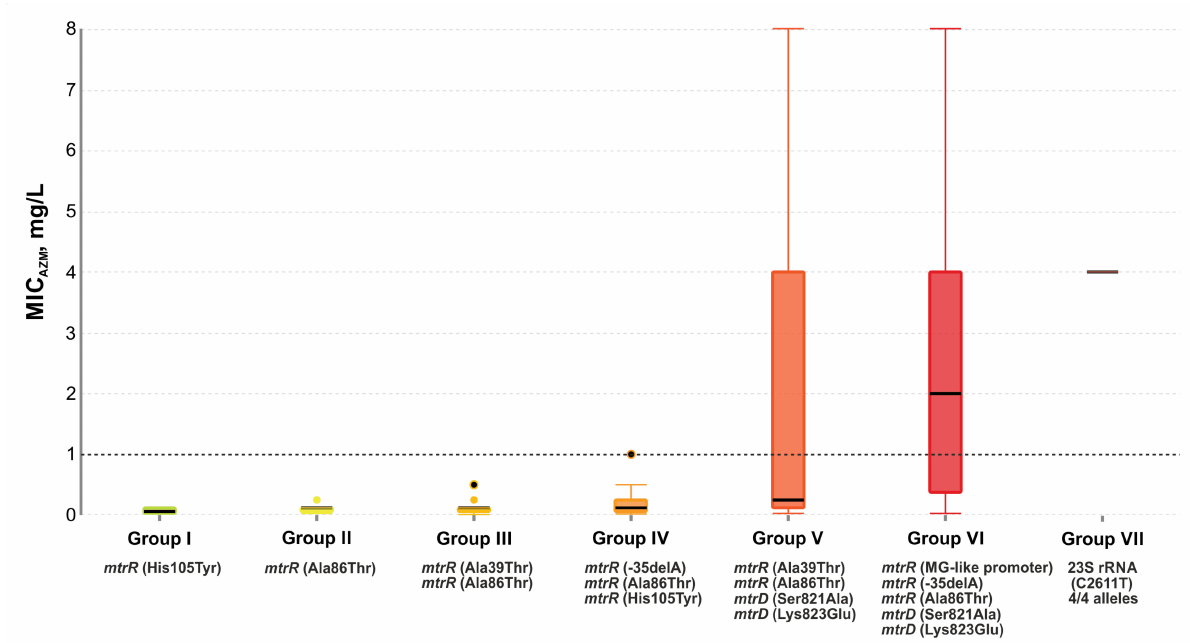
Figure 3. Box plot: MIC Azm in groups of N. gonorrhoeae isolates with different genetic profiles. A description of the profiles by group is given in Table 1. Thick solid lines in each box indicate the median MIC Azm value for each group. The whiskers extend to the boundaries of the interquartile range. The dotted line indicates the EUCAST breakpoint for azithromycin